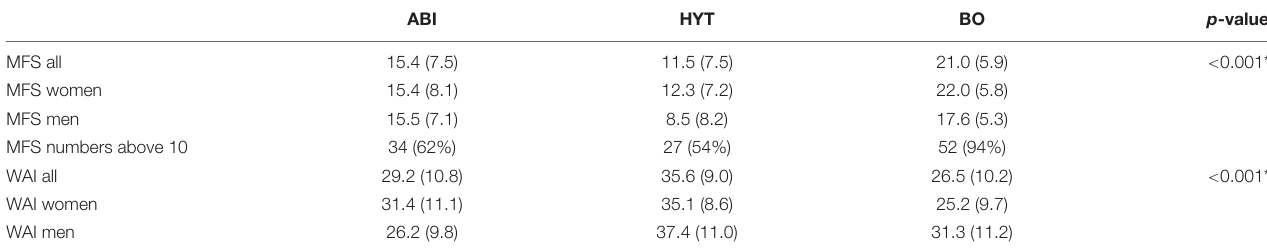
TABLE 2 | The WAI (Work Ability Index), the MFS (Mental Fatigue Scale) ratings for the ABI (acquired brain injury), HYT (hypothyroidism) and BO (burn-out syndrome) groups, and ratings for women and men, respectively. Mean, standard deviation and p -value.